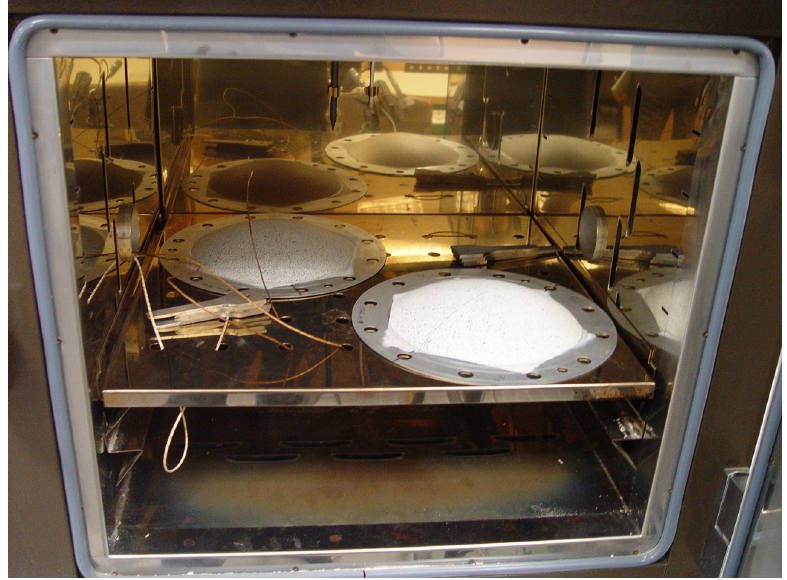
Figure 3. Thermal treatment of bulged